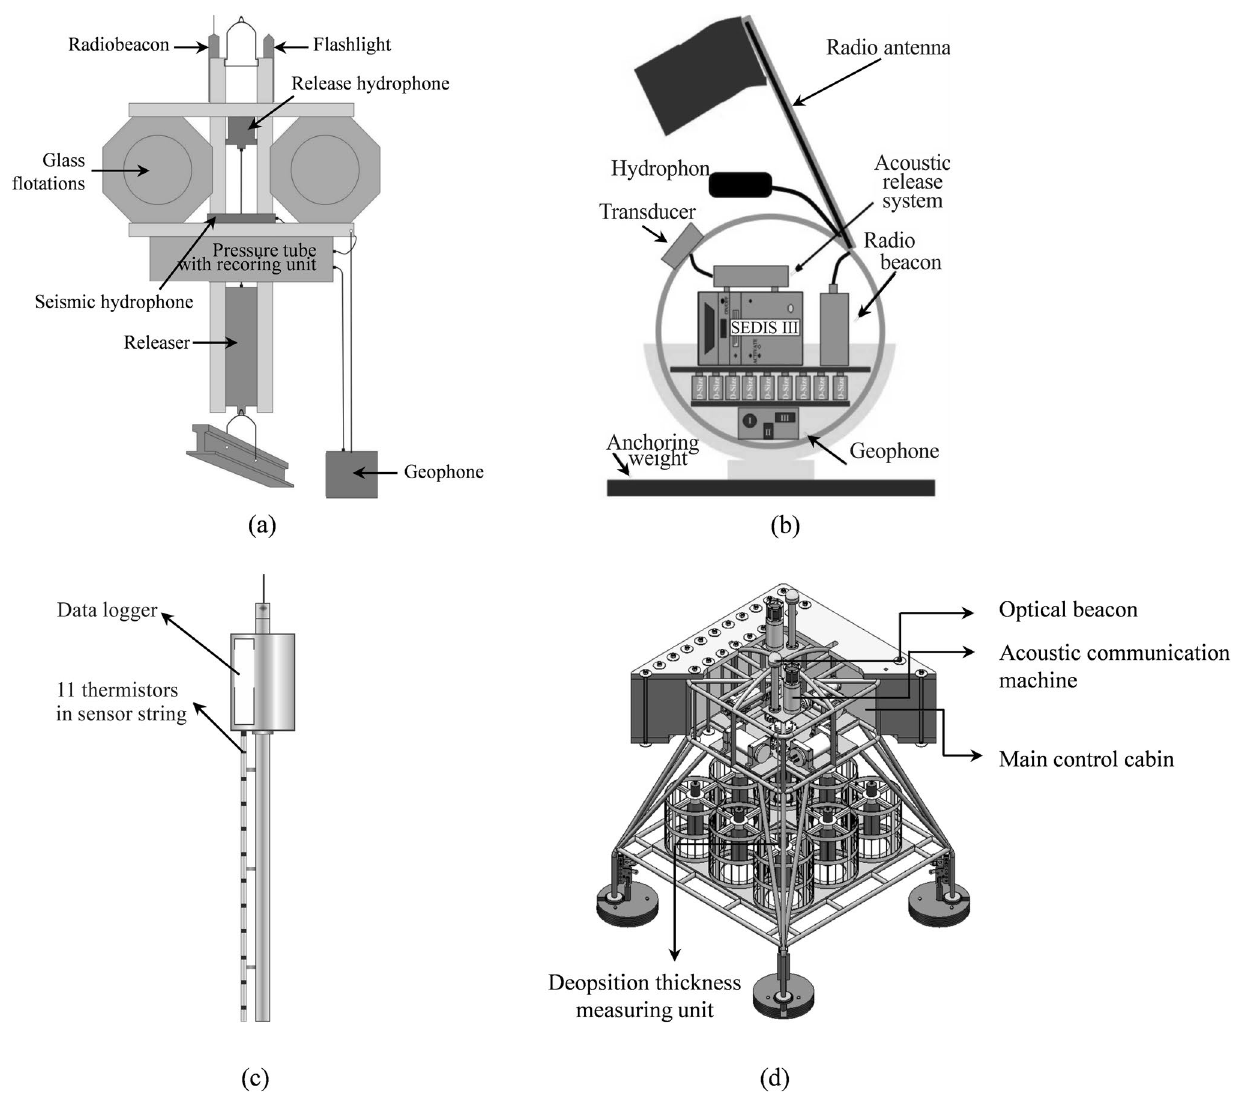
Fig. 19 Systems for the in-situ monitoring of external loads at deep seabed mining sites a Ocean bottom seismograph from the University of Hamburg (modified from Gohl 2003) b Ocean bottom seismograph from GeoPro (modified from Gohl 2003) c Seafloor heat flow probe